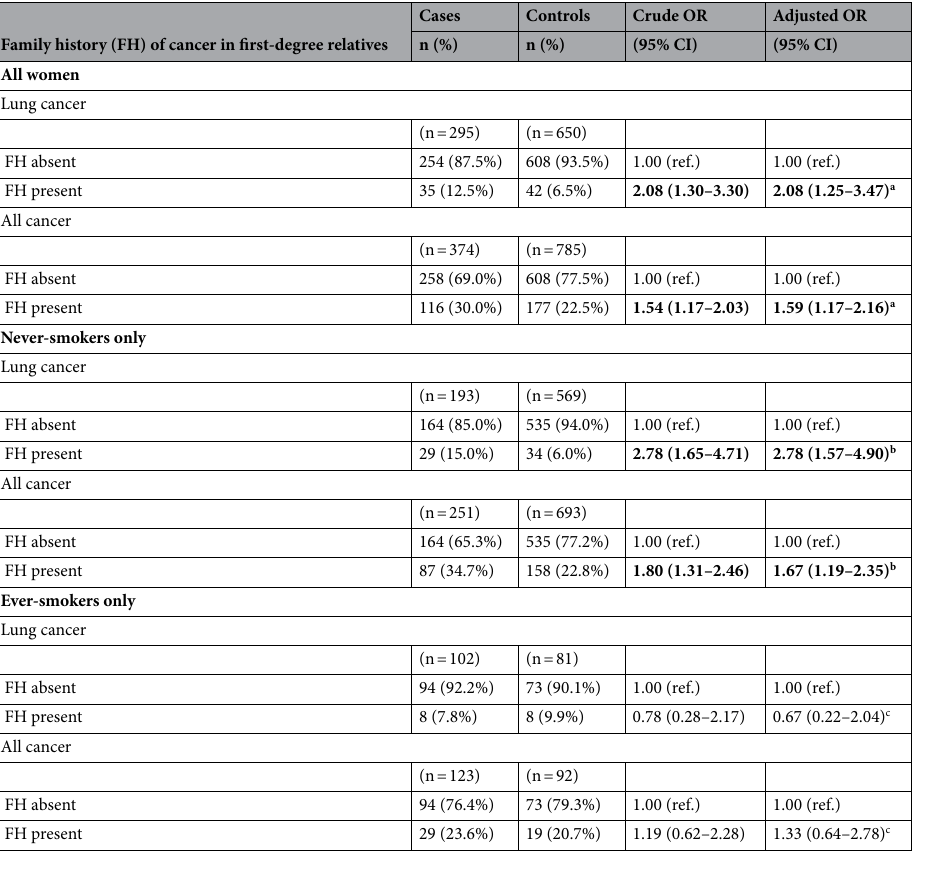
Table 2. Odds ratio (OR) and 95% confidence interval (CI) of the association between family history and lung cancer, stratified by smoking status of women and type of cancer in first-degree relatives. a Adjusted for age, type of dwelling, years of education, ETS exposure, BMI, history of respiratory disease, meat consumption, fruit consumption, vegetable consumption, and smoking status. b Adjusted for age, type of dwelling, years of education, ETS exposure, BMI, history of respiratory disease, meat consumption, fruit consumption, and vegetable consumption. c Adjusted for age, type of dwelling, years of education, ETS exposure, BMI, history of respiratory disease, meat consumption, fruit consumption, vegetable consumption, as well as years of smoking and number of cigarettes per day. Four subjects with family history of lung cancer and five subjects with family history of all cancer had missing data on years of smoking and number of cigarettes per day. Bold values refer to statistically significant results with P